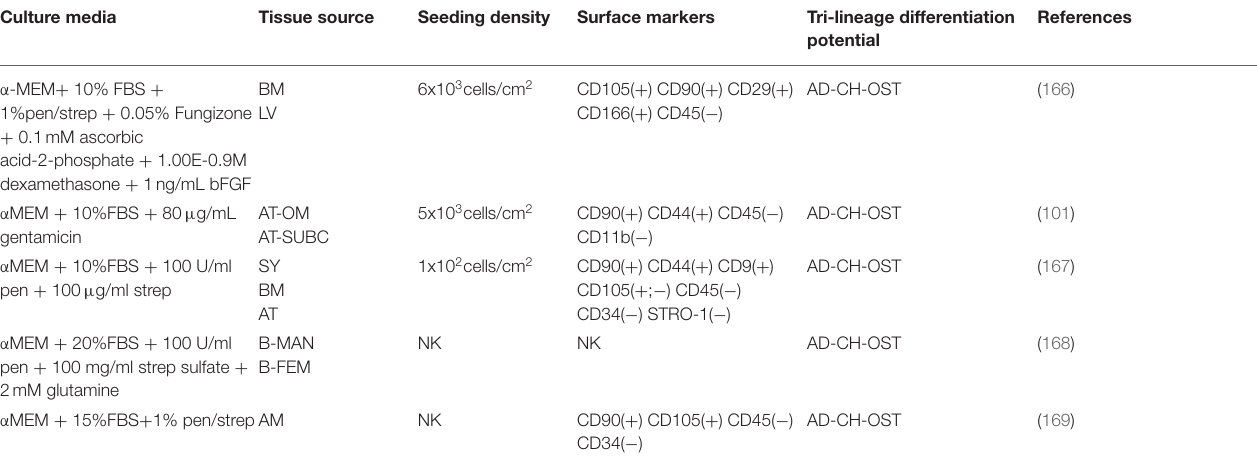
TABLE 2 | Characterization of canine mesenchymal stromal cells cultured in α MEM. Culture